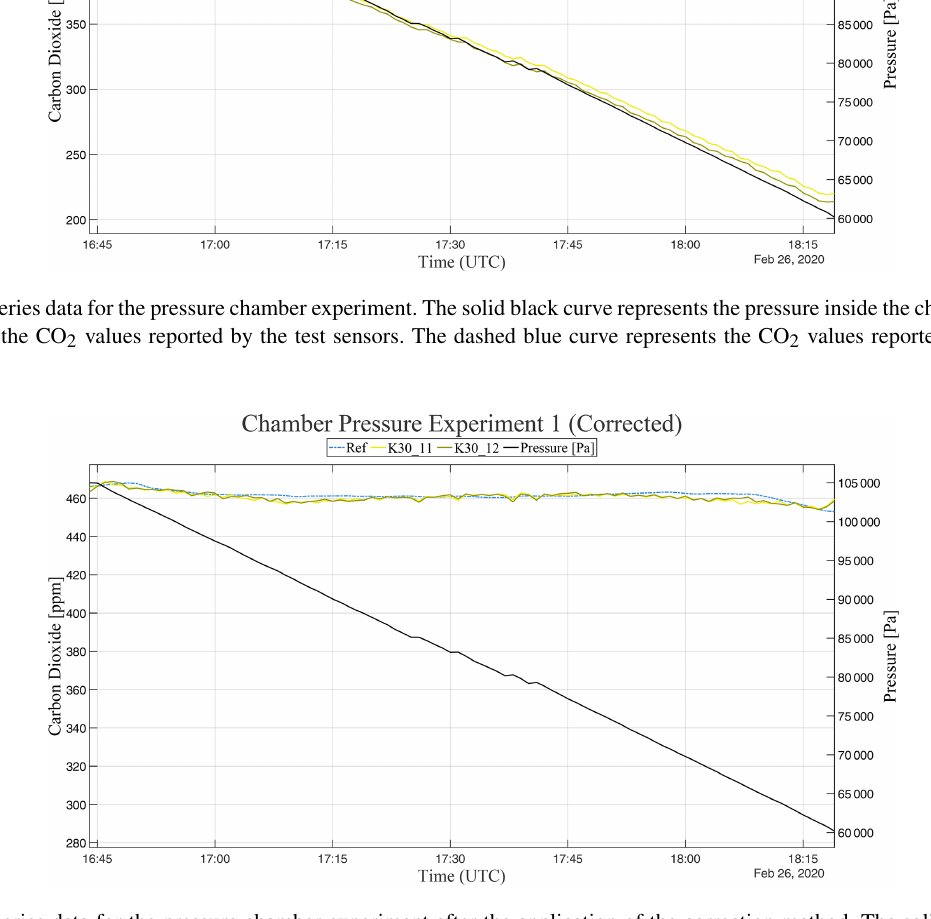
Figure 3. Time-series data for the pressure chamber experiment after the application of the correction method. The solid black curve rep- resents the pressure inside the chamber. The yellow curves represent the CO 2 values reported by the test sensors. The dashed blue curve represents the CO 2 values reported by the reference